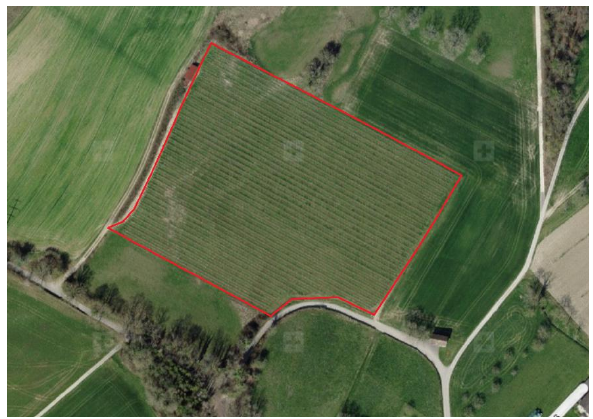
Figure 4: Vineyard chosen as a case study (red box). high accuracy dataset can come from a GNSS-RTK sensor, or by introducing manual GCPs.